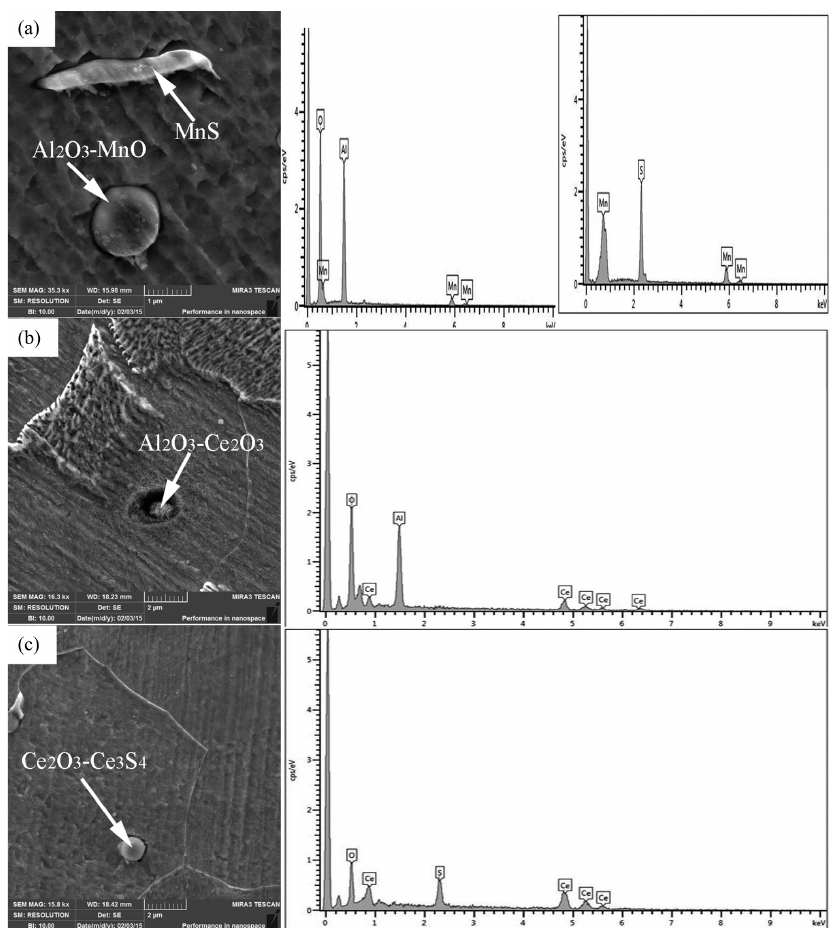
Figure 4: The SEM images and EDS spectra of typical inclusions in tested steels: (a) without Ce, (b) with 0.0020% Ce, (c) with 0.0025%